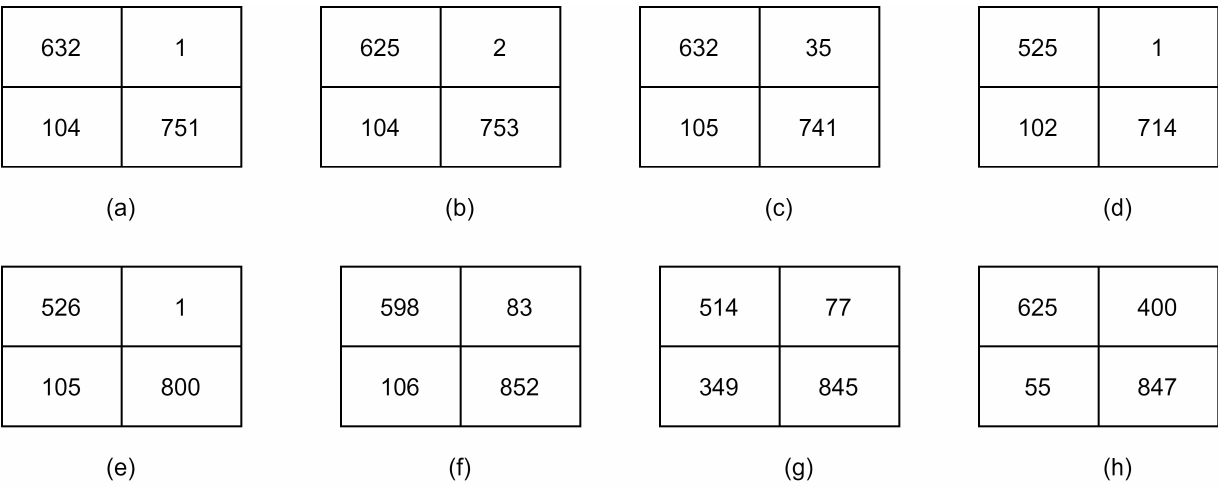
Figure 6. ( a - h ) Confusion